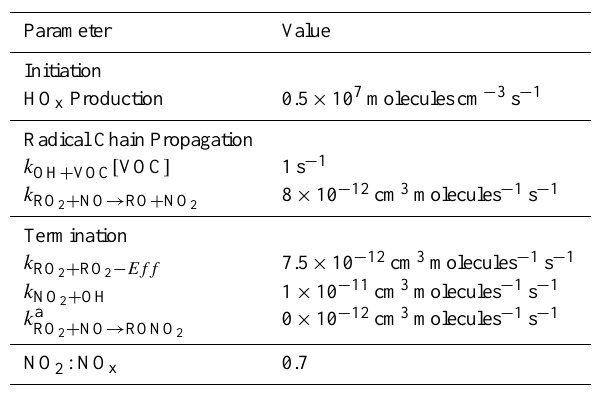
Table 1. Parameters used in HO x -NO x steady-state model (Mur- phy et. al., 2006 and references therein).